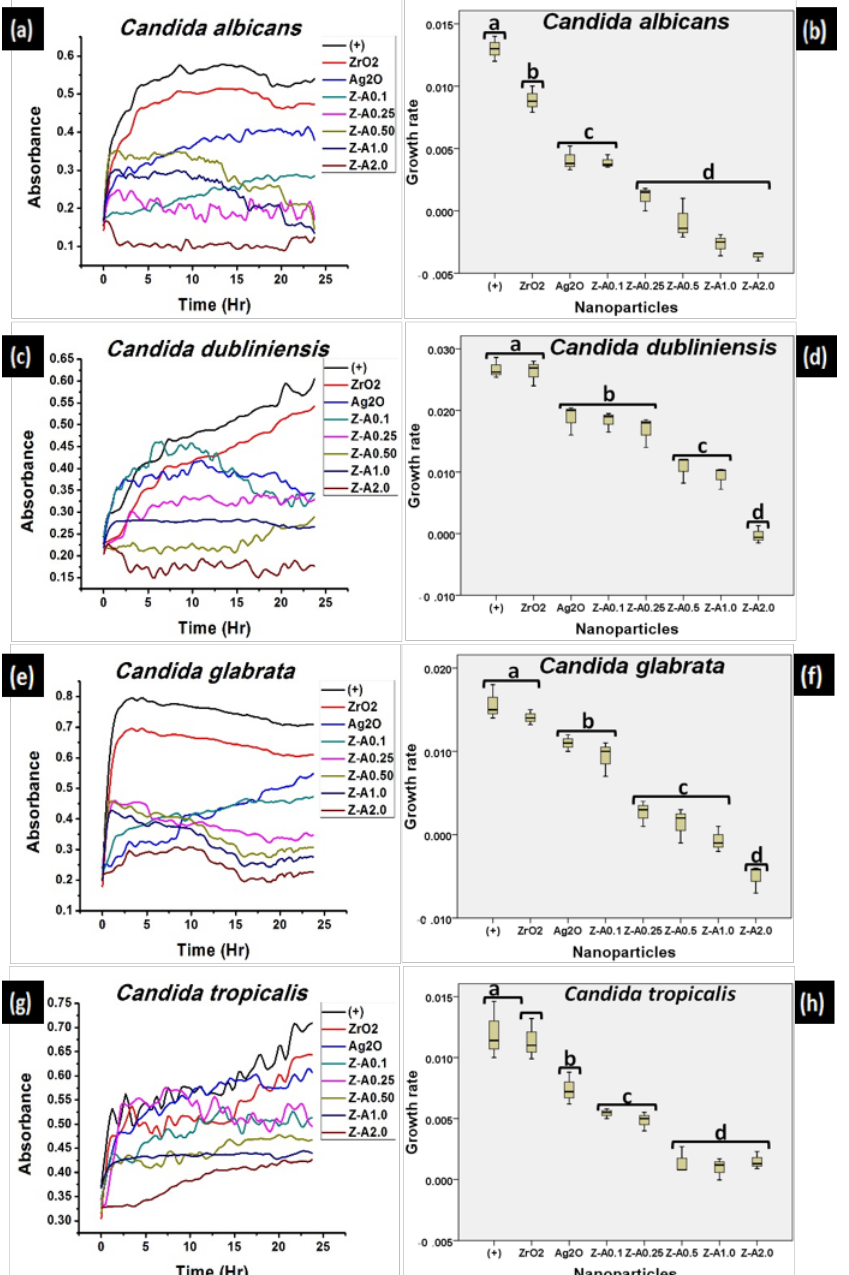
Figure 4. Growth kinetics and statistical computation respectively of ( a , b ) C. albicans, ( c , d ) C. dubliniensis, ( e , f ) C. glabrata, ( g , h ) C. tropicalis by ZrO 2 , Ag 2 O, and Z-A nanoparticles.